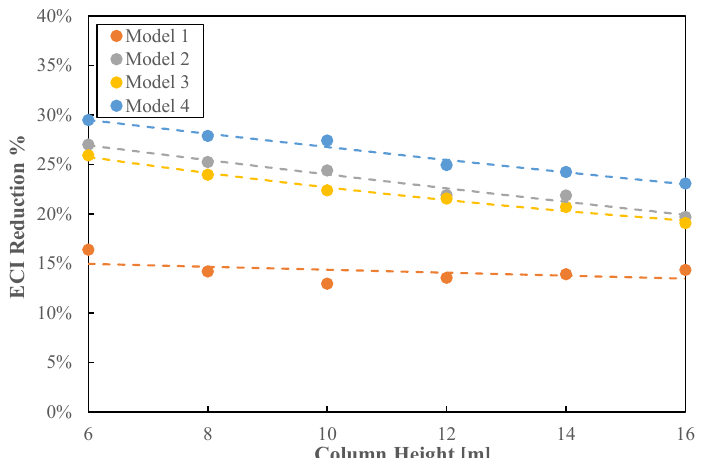
Figure 7. Average ECI reduction variation with column height for different models.